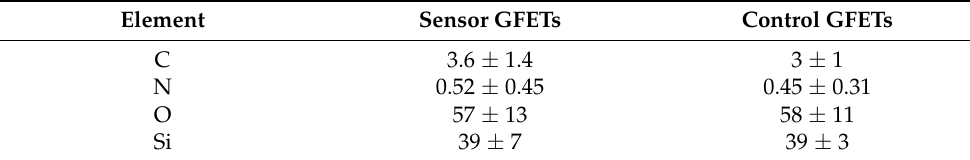
Table 2. EDS data on graphene with and without azide-modified aptamer.